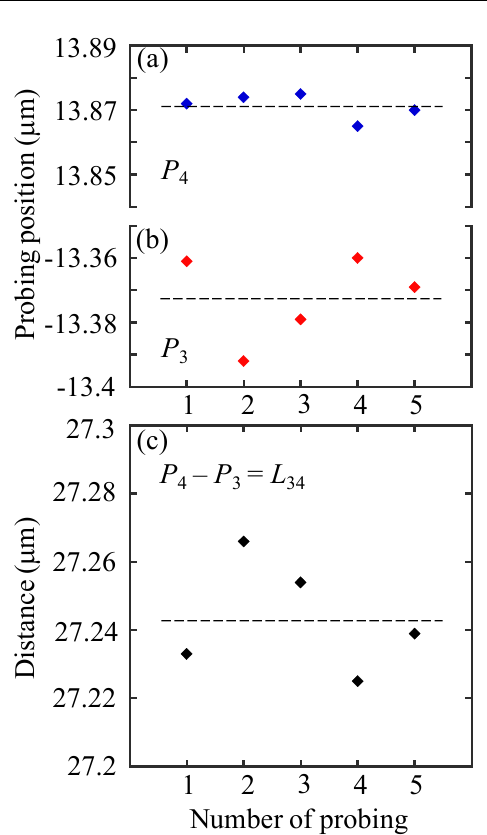
Figure 15. Experimental results of gap width measurement: ( a ) Probing results at P 4 ; ( b ) Probing results at P 3 ; ( c ) Measurement results of L 34 .